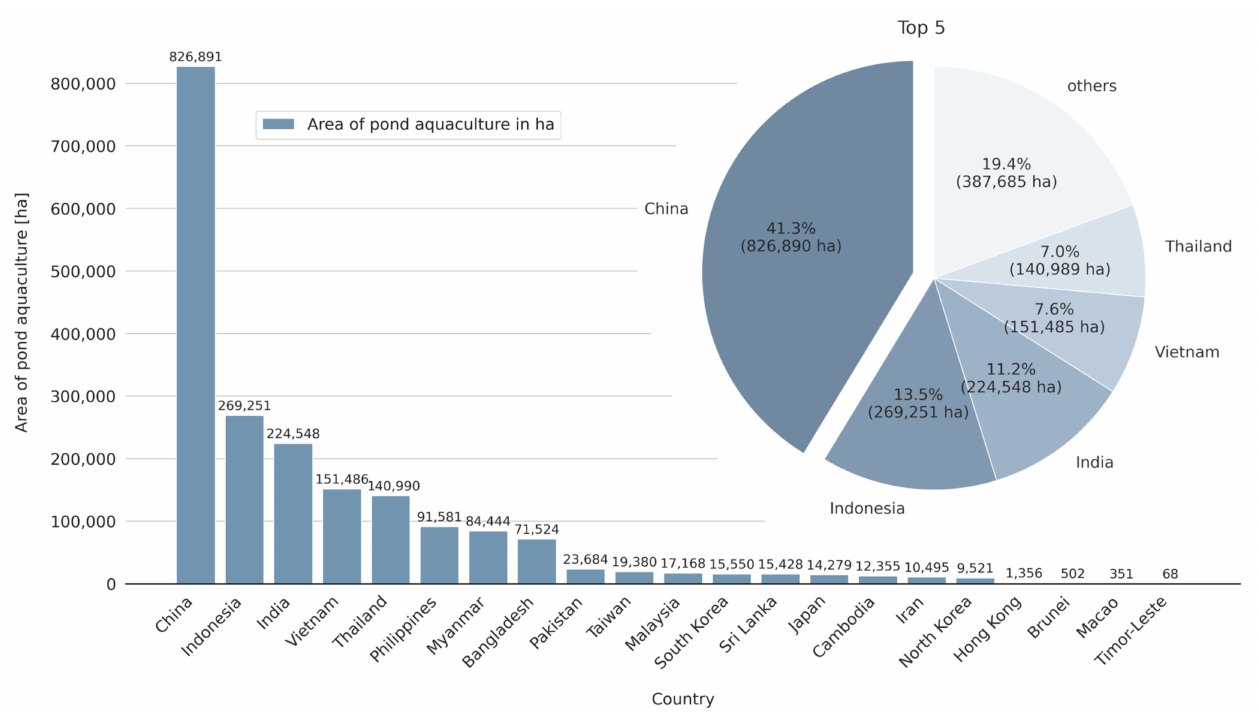
Figure 11. Bar chart: Total area (ha) of the mapped pond aquaculture per country in the study; Pie chart: Share of total mapped aquaculture area (ha) among the top 5 ranking countries (in percent).